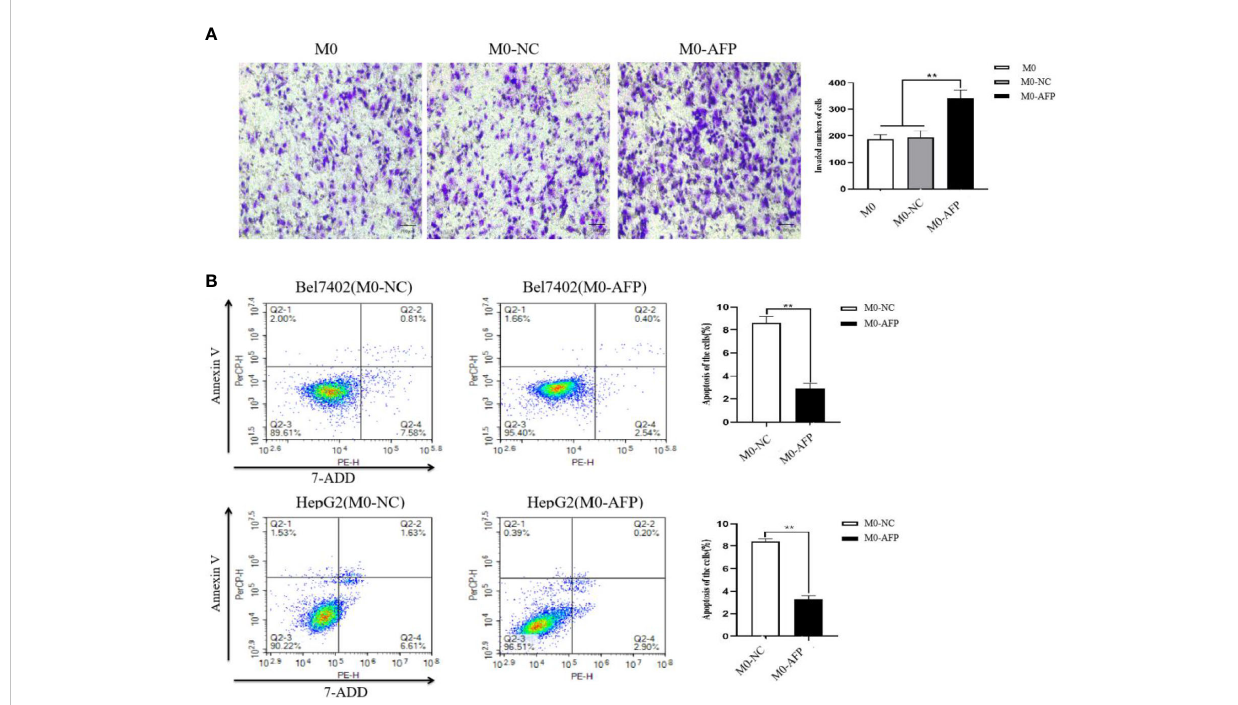
FIGURE 4 Effect of AFP on the migration of macrophages and apoptosis of HCC cells. M0 macrophages were infected with AFP-expressing negative control lentivirus vectors(M0-NC) or AFP-expressing lentivirus vectors(M0-AFP) for 48 h and then treated with LPS+IFN- g for 24 h to induce M0 macrophage polarize into the M1-like phenotype. (A) The number of cells crossing the Transwell chamber membrane in each group was observed by inverted microscope after 72 h, and 5 fi elds were randomly selected to calculate the mean value of cells crossing the membrane; the right column diagram displays the statistical analysis of the number of invaded cells in each group, ** P <0.01. (B) Bel7402 and HepG2 hepatoma cells were co-cultured with M0-NC or M0-AFP, and the effect of macrophages on apoptosis of HCC cells was detected by fl ow cytometry; the right column diagram displays the statistical analysis of the apoptosis rate of liver cancer cells, ** P <0.01. The images are from the at least three independent